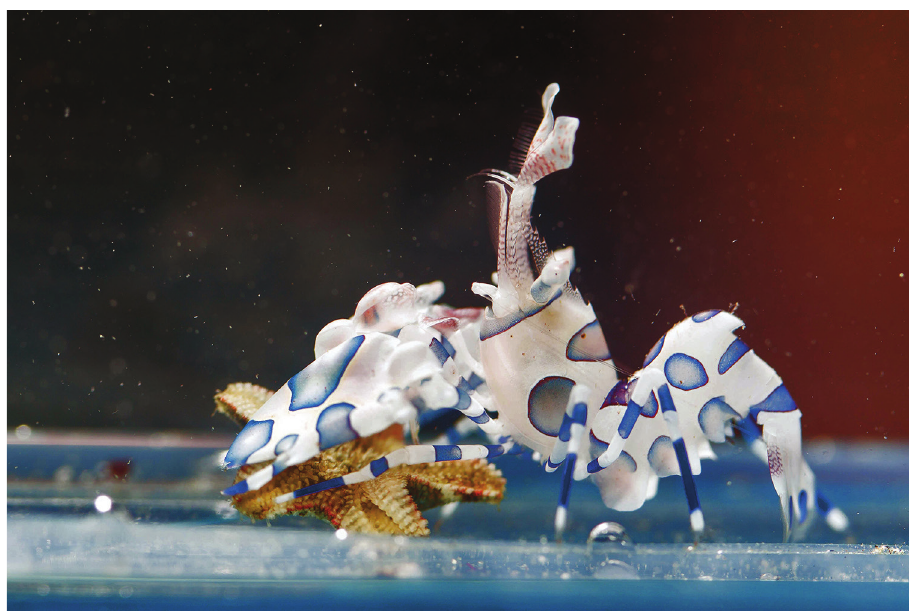
Figure 2. The obligate and voracious echinoderm predator Hymenocera picta (harlequin shrimp) turning an Asterina starfish upside-down and eating the soft tissue from the central